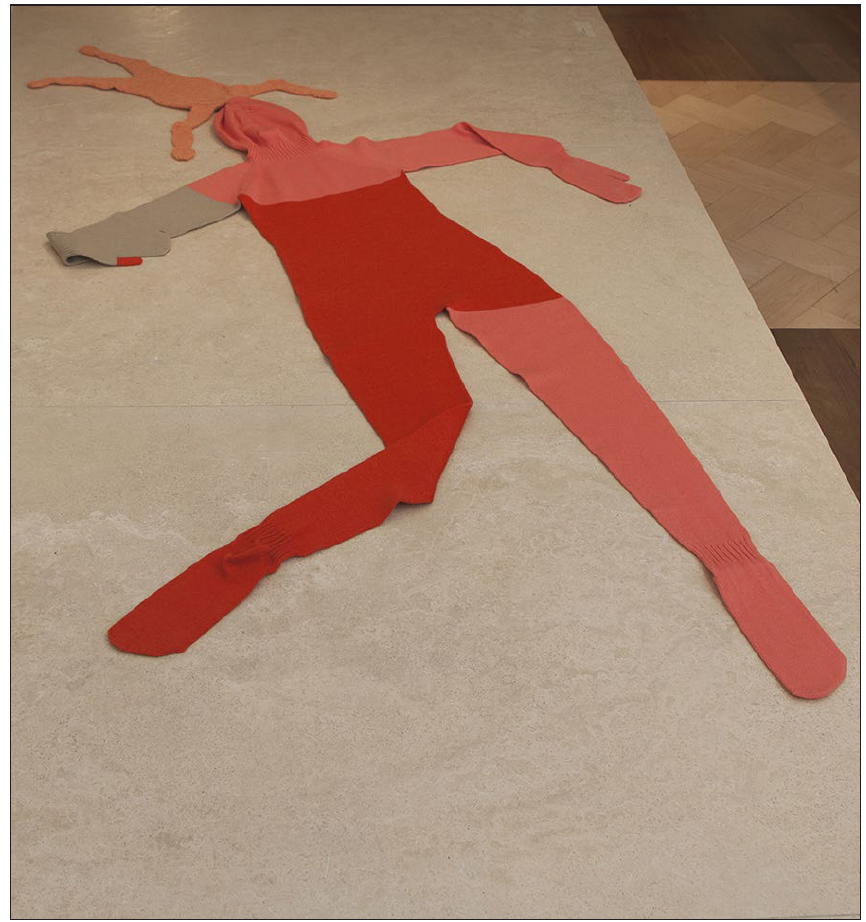
Figure 7: Mad Mother , 2015, machine and hand knitted wool, 2300 × 1520 × 20 mm. Photograph: Stephanie